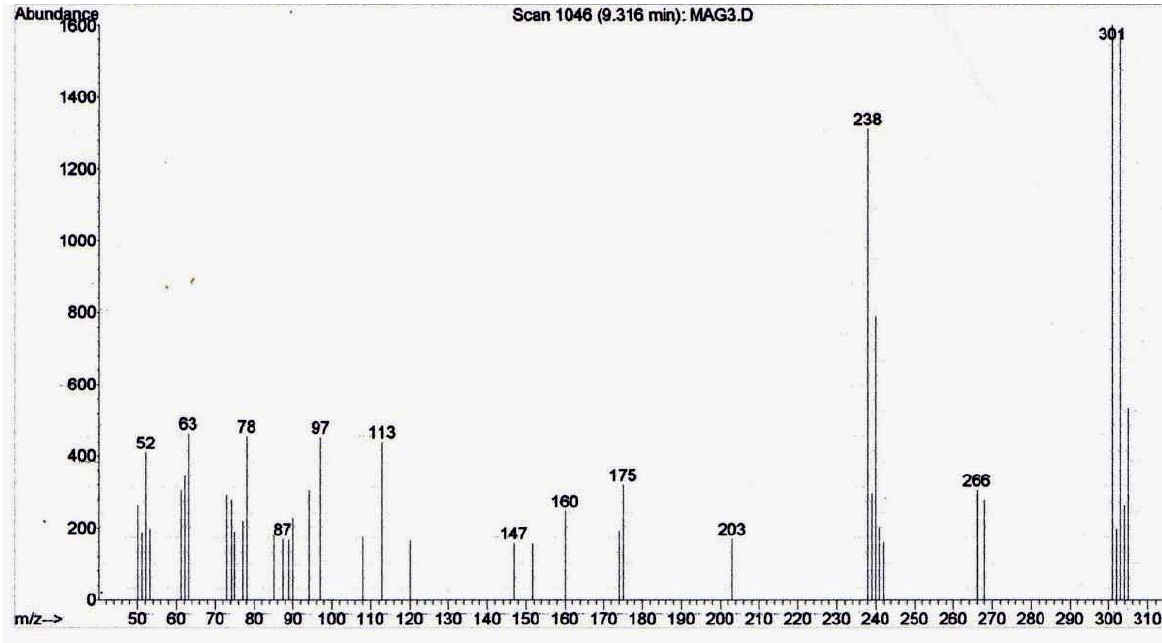
Figure 2. MS spectrum of